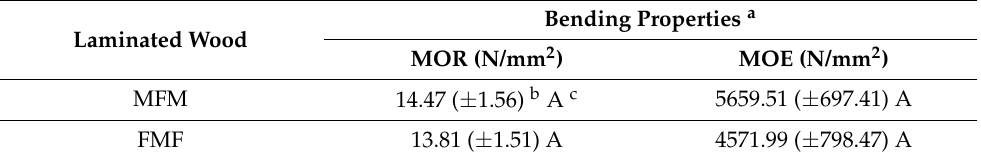
Table 4. Bending properties of the two types of laminated wood.